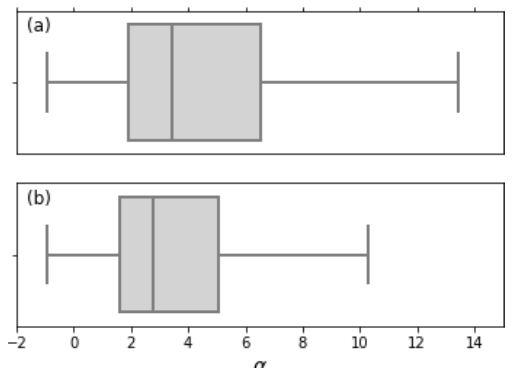
Figure 9. Box-and-whisker plot showing the range of the vertical wind shear α (see (2) for definition) for the (a) top 10% and (b) bot- tom 10% of the probability distribution of the parameterised cool- ing phase (cid:49)T − over the Antarctic Peninsula from the perturbed SSO run for May to October at an altitude of 20.4km, i.e. the most cold (top 10%) and least cold (bottom 10%) of the cooling-phase events. Note that the results are computed within the box indicated in Fig.